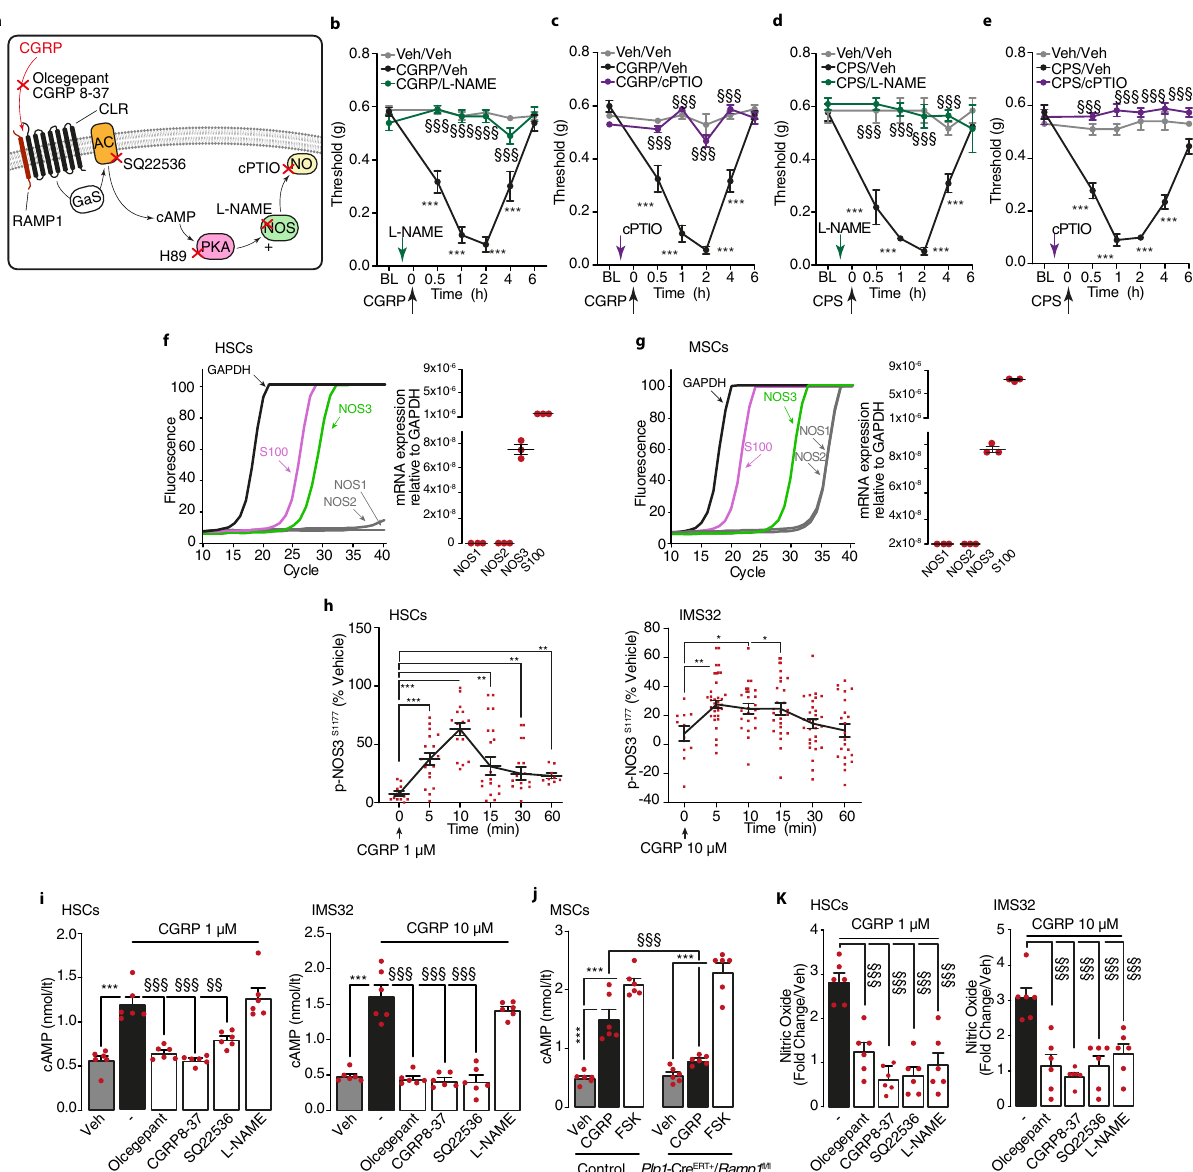
Fig. 6 Endogenous and exogenous CGRP induces PMA via NO production. a Pharmacological targets. b – e PMA after periorbital injection of CGRP (1.5 nmol), capsaicin (CPS, 50 pmol) or vehicle in C57BL/6 J mice pretreated (0.5 h) with L-NAME (1 μ mol) and cPTIO (200 nmol) or vehicle ( n = 8 mice per group). f , g Real-time PCR plot and cumulative data for GAPDH, S100, NOS1, NOS2 and NOS3 in primary HSCs and MSCs ( n = 3 independent experiments). h In-cell p-NOS3 s1177 ELISA in HSCs and IMS32 cells before (time 0, n = 11 independent experiments in both HSCs and IMS32) or after CGRP (time 5, n = 18 and n = 31, time 10, n = 16 and n = 21, time 15, n = 15 and n = 25, time 30, n = 12 and n = 29, time 60, n = 9 and n = 22 independent experiments in HSCs and IMS32, respectively). cAMP assay in ( i ) HSCs, IMS32 and ( j ) MSCs from Plp1-Cre ERT + / Ramp1 fl / fl or Control mice treated with intraperitoneal 4-OHT, k nitric oxide assay in HSCs and IMS32 cells treated with CGRP or vehicle ( n = 6 independent experiments). Some cells were treated with olcegepant (1 µ M), CGRP8-37 (1 µ M), SQ22536 (100 µ M), L-NAME (100 µ M) or vehicle ( n = 6 independent experiments). Mean±SEM. ( − ) represents the combination of different vehicles. * P < 0.05, ** P < 0.01, *** P < 0.001 vs. Veh/Veh, time 0 (min); §§§ P < 0.001 vs. CGRP/Veh, CGRP 1 µ M and 10 µ M. 1-way ( h – k ) or 2-way ( b – e ) ANOVA, Bonferroni correction. Source data are provided as a Source Data fi